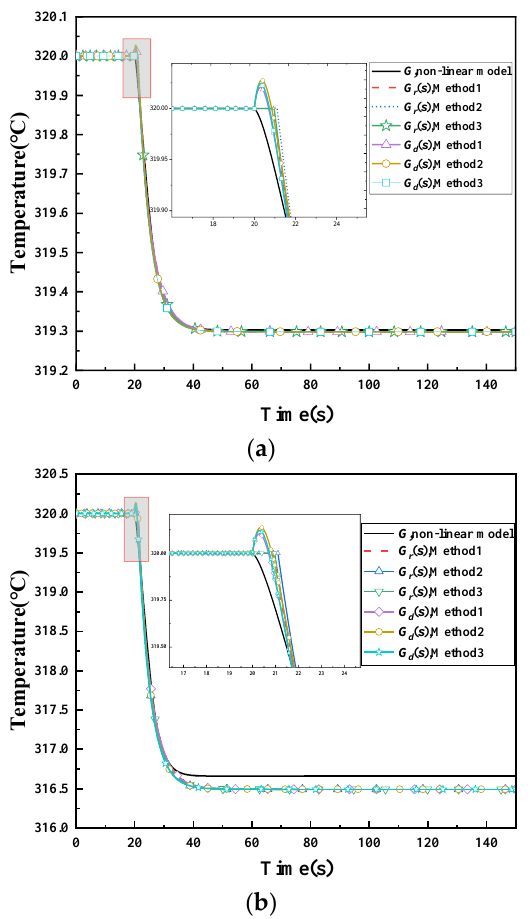
Figure 8. Comparison between simplified model and nonlinear model: ( a ) +1% feedwater flowrate disturbance, ( b ) +5% feedwater flowrate disturbance.